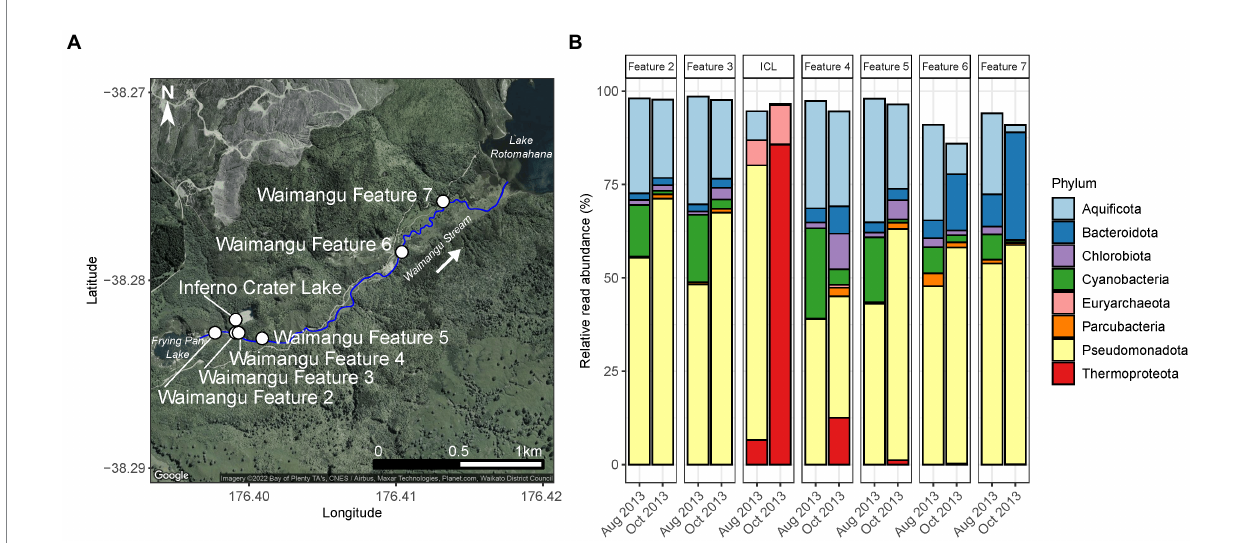
FIGURE 1 Short-term, natural disturbance of Waimangu Stream by Inferno Crater Lake. (A) Waimangu Stream (outlined by the solid blue line) originates from Frying Pan Lake and flows down a rift valley to Lake Rotomahana. Sampling locations along the stream (Waimangu Features 2–7) are depicted by white circles, along with Inferno Crater Lake which overflows into Waimangu Stream every ~30–40 days. Waimangu Features 2 and 3 are upstream of the Inferno Crater Lake overflow (by ~150 and 10 m, respectively), while Waimangu Features 4–7 are downstream (by ~35, 200, 1,400, and 1,950m, respectively). (B) Microbial community composition and relative abundance of Waimangu Stream features and Inferno Crater Lake (ICL) before (August 2013) and during (October 2013) the disturbance, measured by amplicon sequencing of the 16S rRNA gene. Only phyla >1% average relative abundance across all samples in this category are